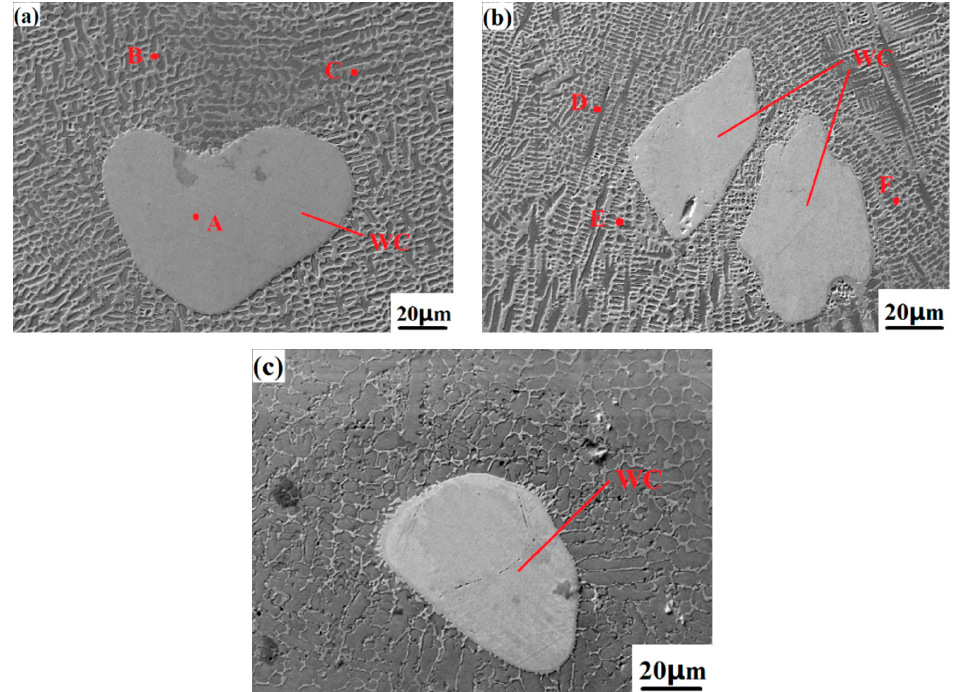
Figure 5. Microstructure image around WC particles in Co-Cr-30%WC cladding layer. ( a ) Slightly dissolving-diffusing WC particles; ( b ) Slightly dissolving-diffusing WC particles; ( c ) Slightly dissolving-diffusing WC particles. Table 2. Analysis of EDS points in the section of Co-Cr-30%WC cladding layer (wt.%).